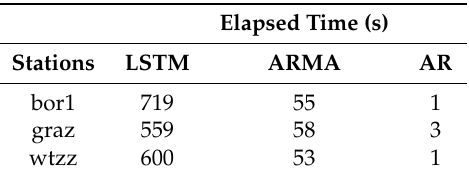
Table 4. Computational time (in s) per method (LSTM, ARMA and AR) for three selected stations (bor1, graz and wtzz).